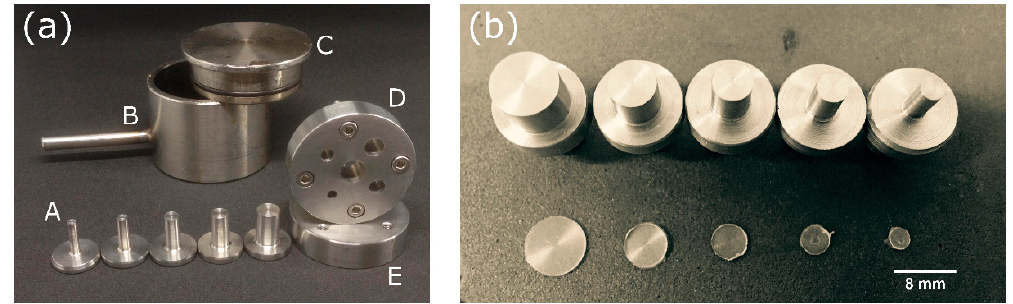
Figure 1. ( a ) Vacuum mold used to shape the samples: A, inner pistons (diameters in mm are indicated in the figure); B, vacuum chamber; C, sealing cap; D, mold; E, lower plate. ( b ) Parallel plates of different diameters used for linear measurements, along with samples obtained with vacuum compression molding